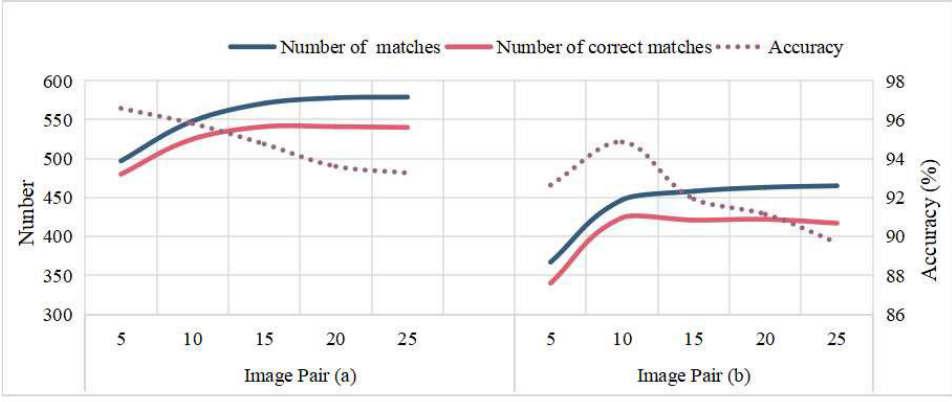
Figure 8. Performance of our approach with different T θ for Figure 7a,b image pairs.